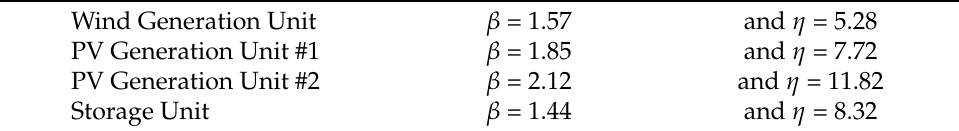
Table 2. Weibull shape and scale factor of each generation unit’s failure